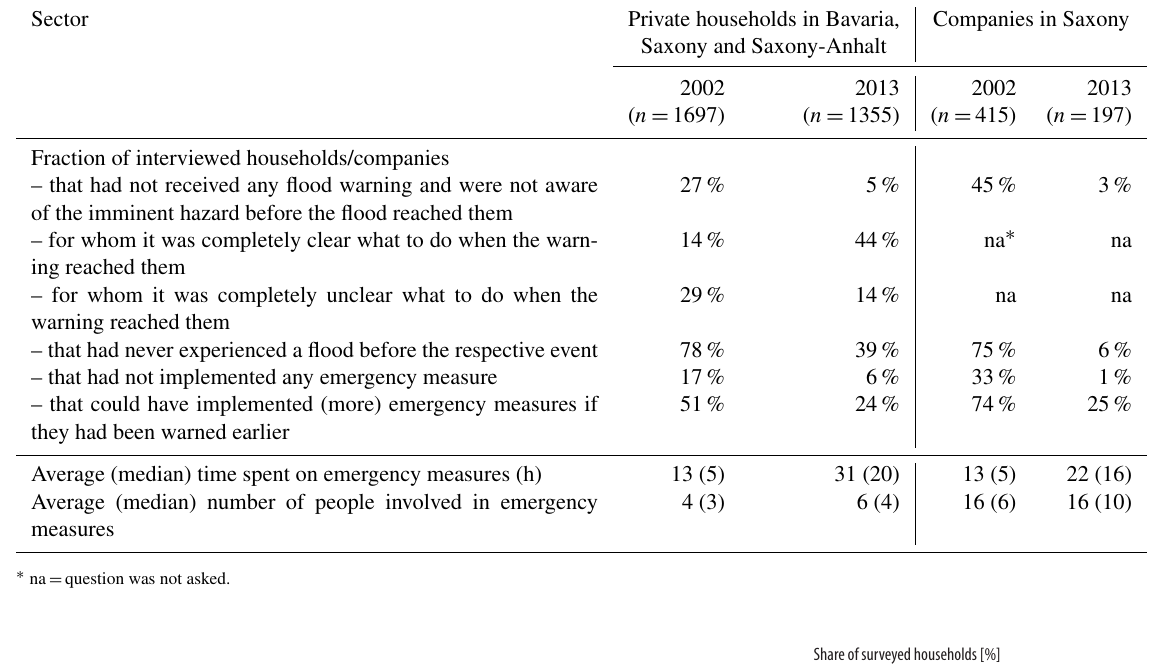
Table 2. Information of all interviewed private households from Bavaria, Saxony and Saxony-Anhalt together (federal state specific infor- mation is provided in Figs. 2, 5 and 7) as well as from interviewed companies in Saxony. Sector